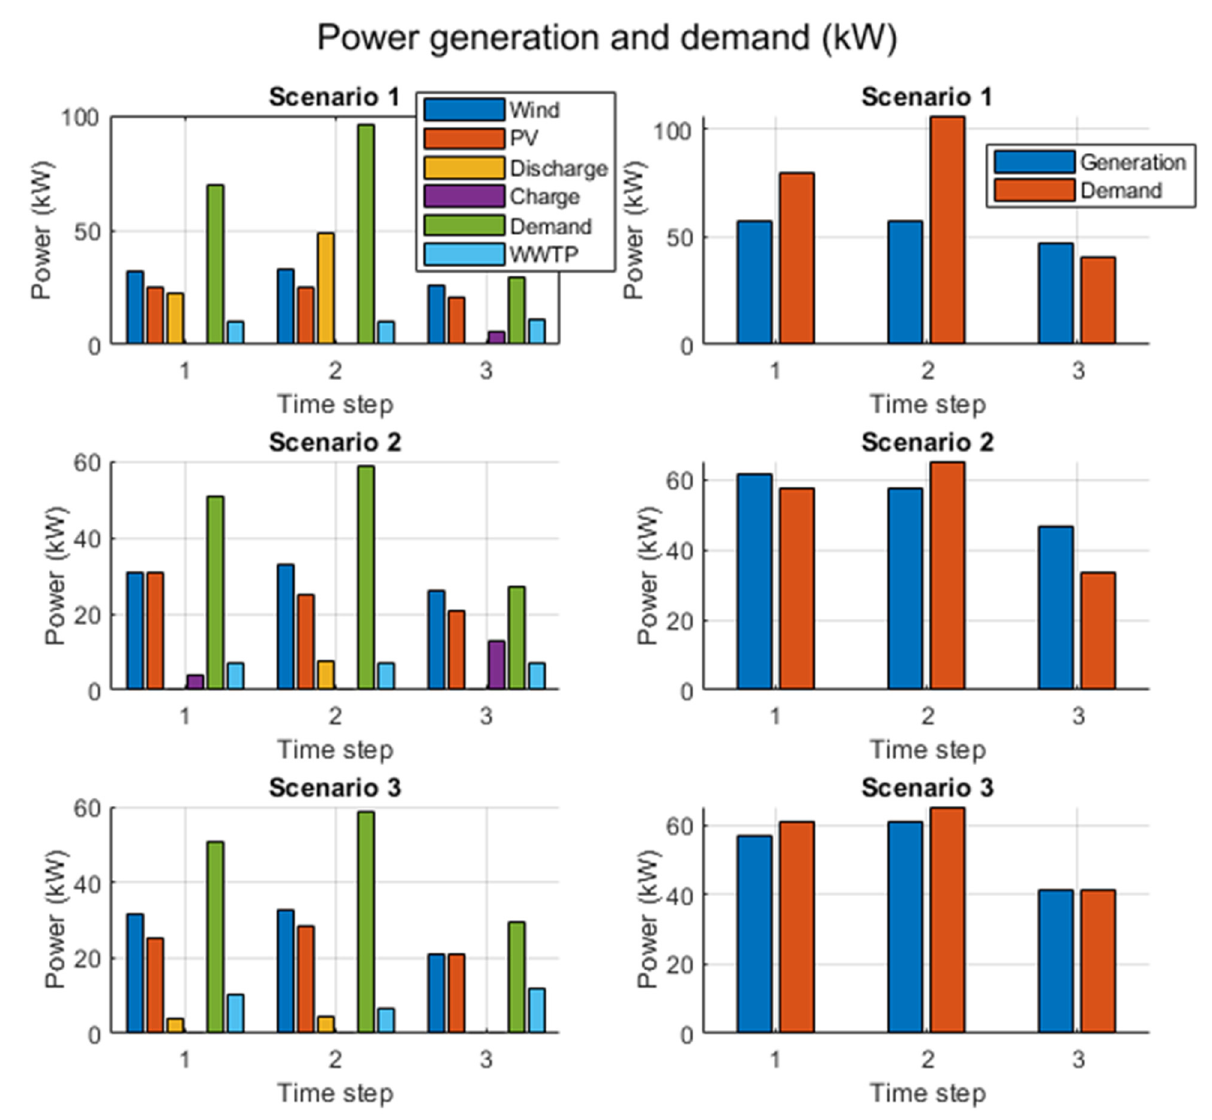
Figure 2. Graphs on the left show hourly power generation from individual sources at different time-steps and power demand at corresponding times, during the three representative scenarios. The graphs on the right side illustrate the total power generation (from wind and PV) and total power demand, for different scenarios and at different times.